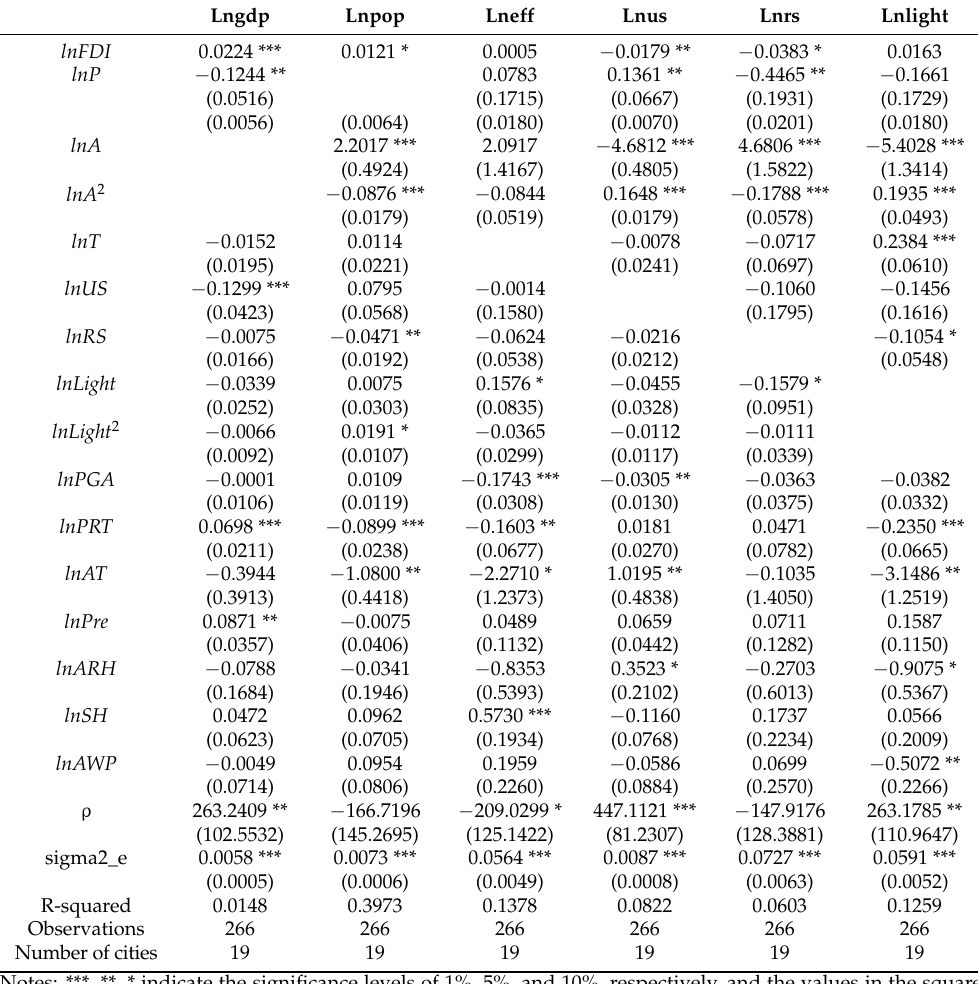
Table 7. Empirical results of the mechanism of FDI effects on PM 2.5